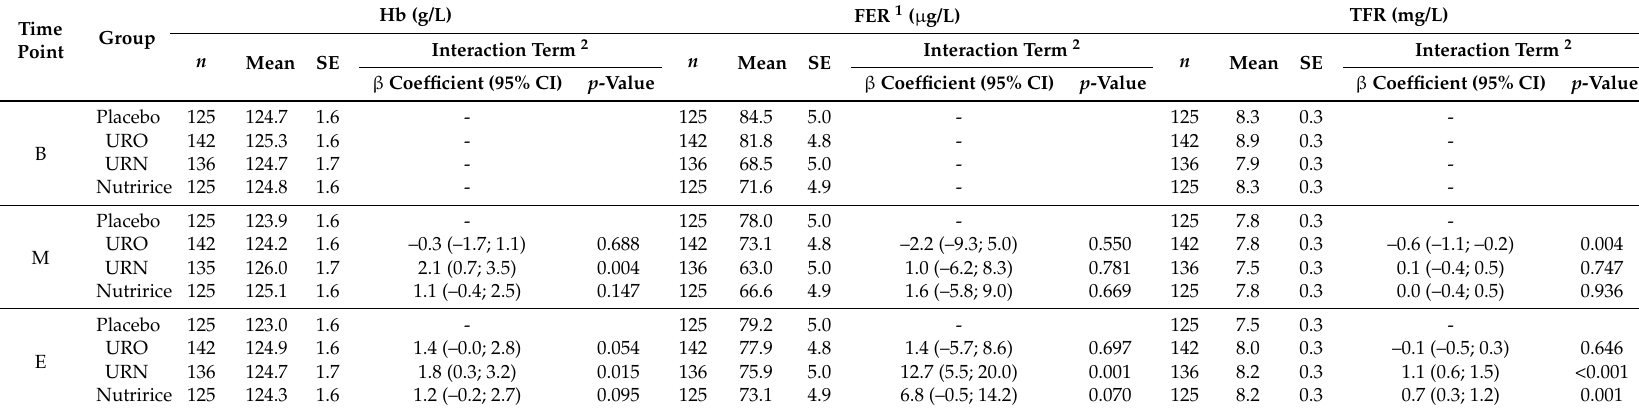
Table 5. Biochemical outcomes and effect sizes after three and six months of intervention for the sub-sample of children with no inflammation at baseline, midline, and